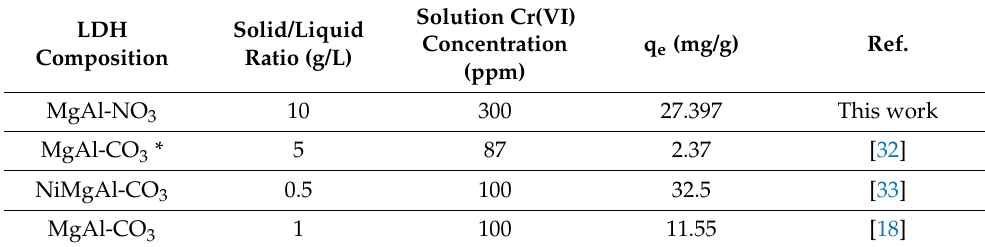
Table 2. Adsorption capacity of MgAl-LDHs for